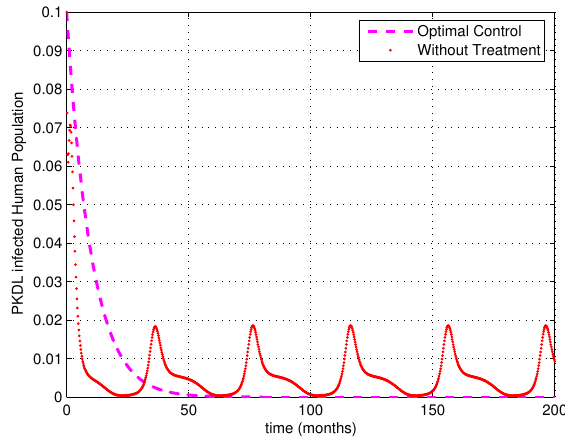
Figure 4. Simulation results showing post-kala-azar dermal leishmaniasis